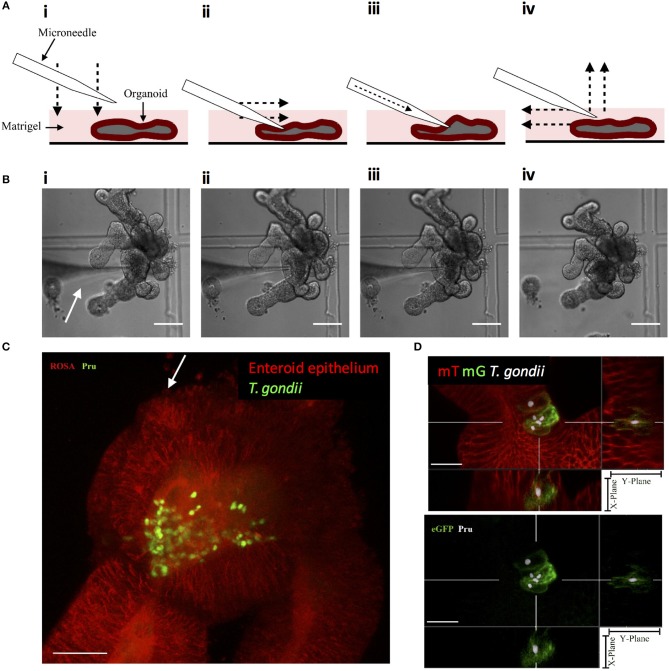
Microinjection of T. gondii into the enteroid lumen results in successful invasion of epithelial cells. (A) Schematic of the optimized technique for inserting microneedles into the lumen of enteroids. (i) the microneedle is lowered onto the enteroid to, (ii) press down on the enteroid surface. The microneedle is moved laterally to pierce the enteroid. (iii) The contens of the loaded microneedle are injected into the enteroid lumen. (iv) The microneedle is removed from the enteroid lumen by moving up and laterally away. (B) Bright field images corresponding to the technique described in (A). White arrow indicates the microneedle. Scale bar: 100 μm. (C) ROSAmT/mG enteroids were microinjected with T. gondii Pru-GFP. Image depicts a single time-point from a two-photon time-lapse movie. Parasites (green) are present in the enteroid lumen (red). White arrow indicates injection site. Scale bar 30 μm. (D)
T. gondii Pru-tdTom-Cre were loaded into microneedles at 4 × 109/mL, microinjected into ROSAmT/mG enteroids, and incubated for 48 h. Samples were fixed and z-stack images obtained by confocal microscopy. Images were analyzed by Imaris with T. gondii pseudo-colored for clarity. A cross-section of the infected enteroid showing intracellular parasites within mG+ cells. Scale bar 15 μm. 63x objective.